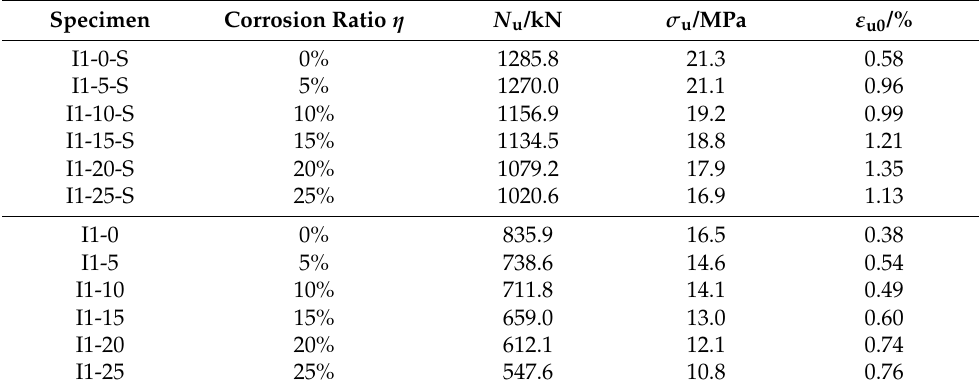
Table 6. Test results of the axial compression